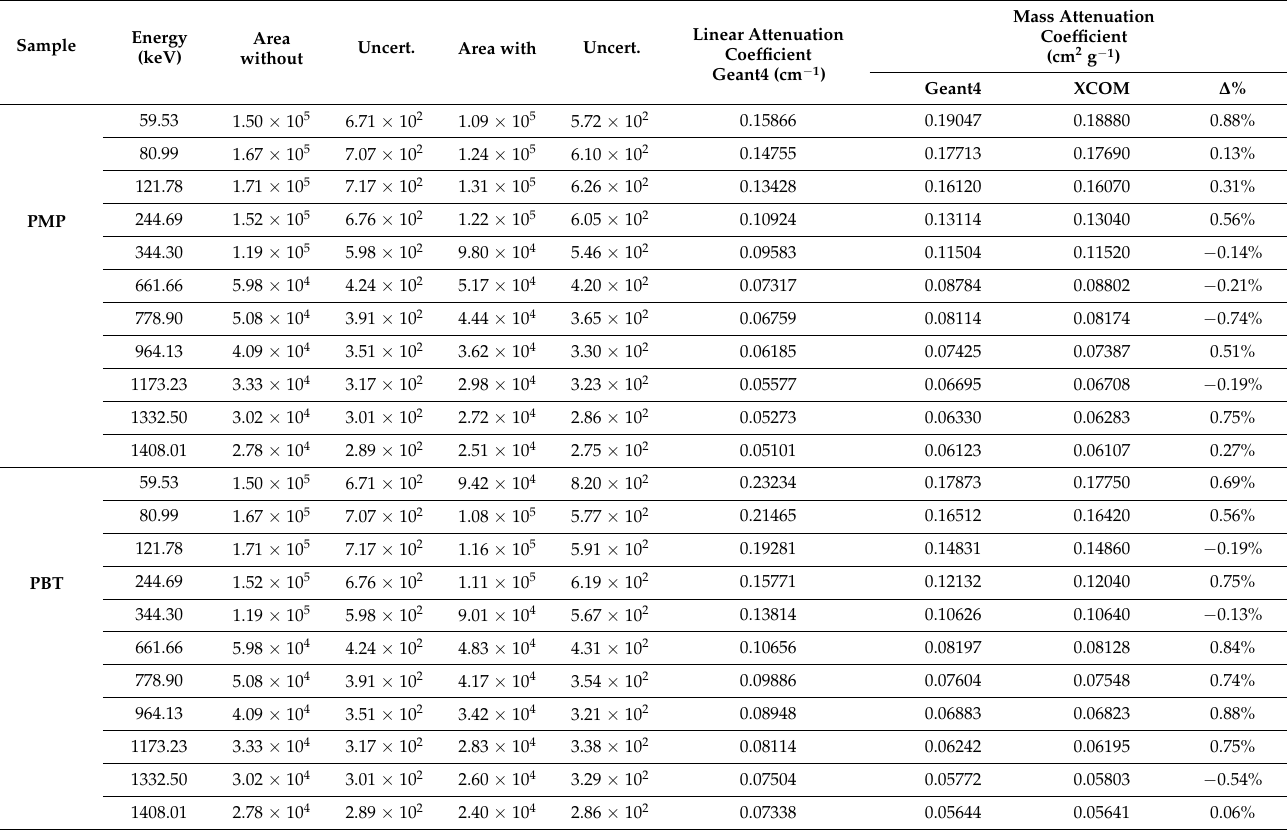
Figure 2. The energy spectra from shielded and unshielded simulations at different two energies ( a ) at 81 and ( b ) 1173 keV. Table 2. Comparison between mass attenuation coefficients for the polymer materials using XCOM software online [32] and Geant4 code at various photon